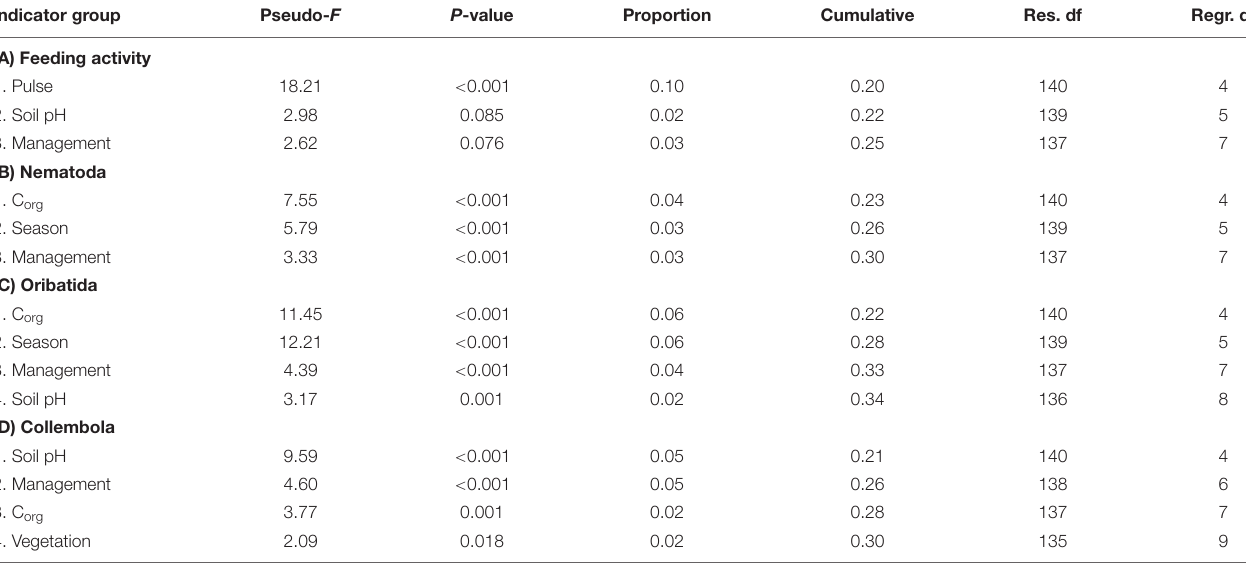
Indicator groups are given in the order of model selection with experimental fertilization treatment (pulse), soil pH values, long-term nutrient management, soil organic carbon content (C org ), season and vegetation properties. Pseudo-F and P-values are provided together with the individual and cumulative proportion of explained